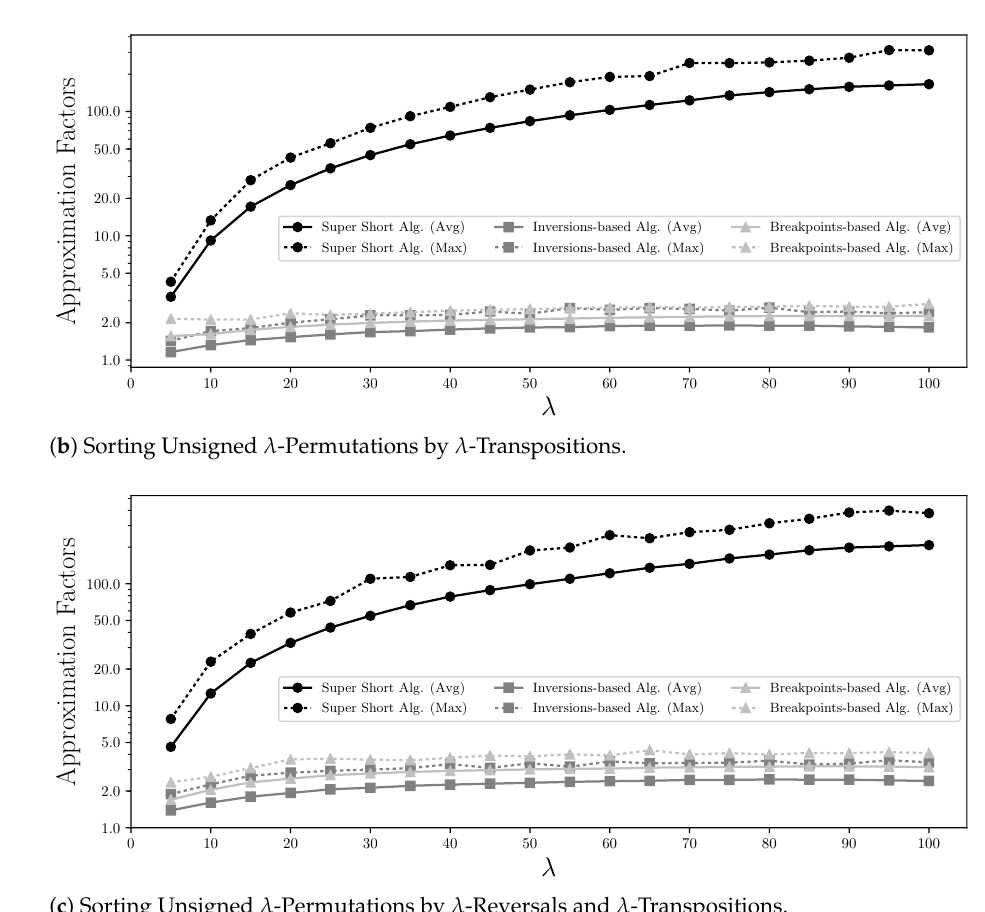
Figure 4. Average and maximum approximation factors of the algorithms for Sorting Unsigned λ -Permutations by λ -Operations, with random λ -permutations generated from ι of size 100 as inputs. Note that a logarithmic scale is used in the y-axis of each